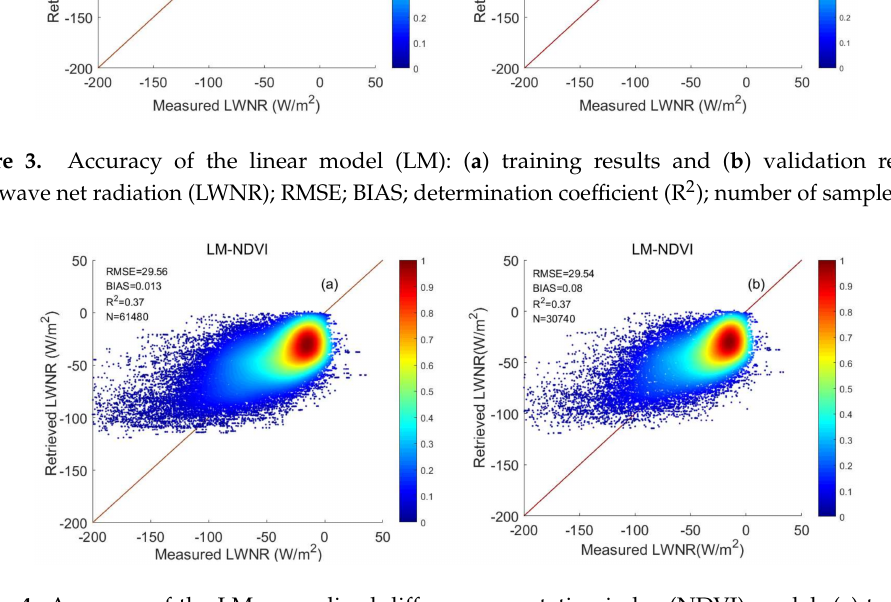
Figure 4. Accuracy of the LM-normalized difference vegetation index (NDVI) model: ( a ) training results and ( b ) validation